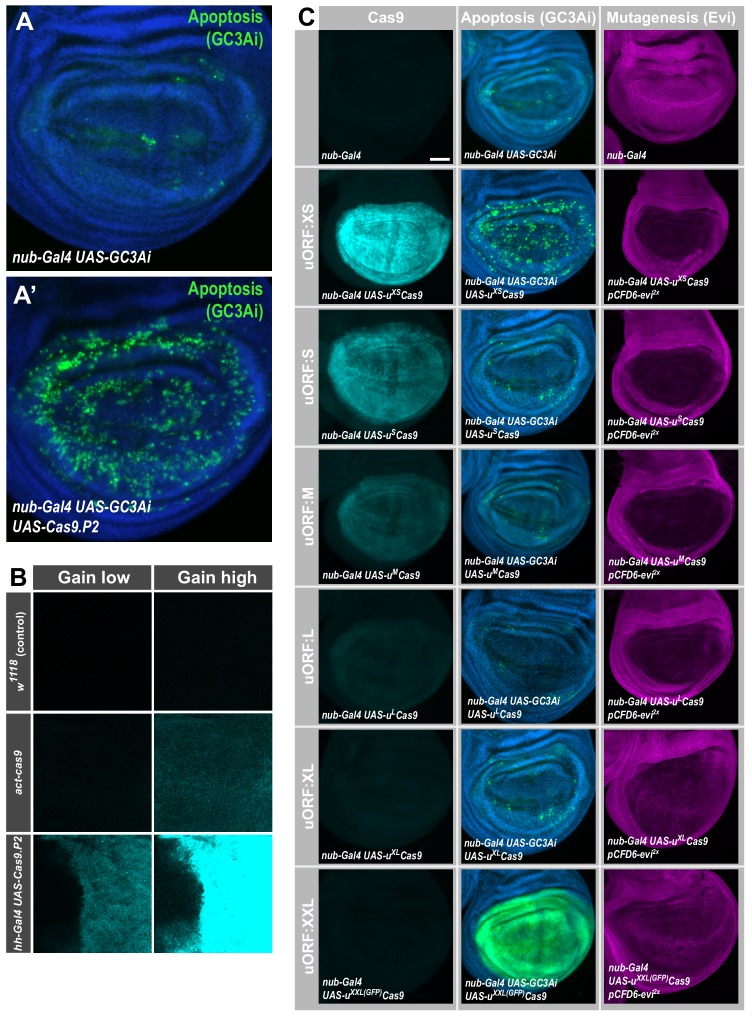
High levels of Cas9 expression from UAS-cas9.P2 are cytotoxic. (A) Expression of Cas9 in nub-Gal4 UAS-Cas9.P2 causes excessive cell death. Apoptotic cells were visualized by co-expression of GC3Ai, which is fluorescent in cells with activated caspase 3. Expression of GC3Ai in the wing pouch highlights a few cells undergoing apoptosis. Additional expression of UAS-cas9.P2 causes a dramatic increase in the cells undergoing programmed cell death, highlighting cytotoxicity caused by high levels of Cas9. (B) Comparison of Cas9 expression levels between act-cas9 and hh-Gal4 UAS-cas9.P2 wing discs. Cas9 was detected by antibody staining and imaged in the same session with identical setting at either low (top panel) or high (bottom panel) detector gain. The difference in Cas9 levels is such, that Cas9 expressed from act-cas9 is undetectable with low detector gain and Cas9 staining in hh-Gal4 UAS-cas9.P2 wing discs is oversaturated with high detector gain, where Cas9 from act-cas9 is visible. The act-cas9 transgene is known to mediate highly efficient mutagenesis in Drosophila (Port et al., 2014; Port et al., 2015 ). (C) Systematic characterization of Cas9 expression, toxicity and mutagenesis of the UAS-uCas9 series. Transgenes of the UAS-uCas9 series were recombined with nub-Gal4 and wing imaginal discs were stained for Cas9 protein. Cas9 levels gradually reduce as the size of the uORF increases (left panel). nub-Gal4 UAS-uCas9 flies were crossed to UAS-GC3Ai to visualize cells undergoing apoptosis. Elevated levels of apoptosis were only observed with UAS-uXSCas9. The longest uORF (uXXL) encodes EGFP, preventing visualization of dying cells with GC3Ai (middle panel). nub-Gal4 UAS-uCas9 flies were crossed to pCFD6-evi2x and mutagenesis of evi was indirectly observed by loss of Evi staining. All transgenes of the UAS-uCas9 series mediate evi mutagenesis, with transgenes containing the four shortest uORFs (XS-L) leading to comparable gene editing that removes Evi from nearly all cells in the Gal4 expression domain (right panel).